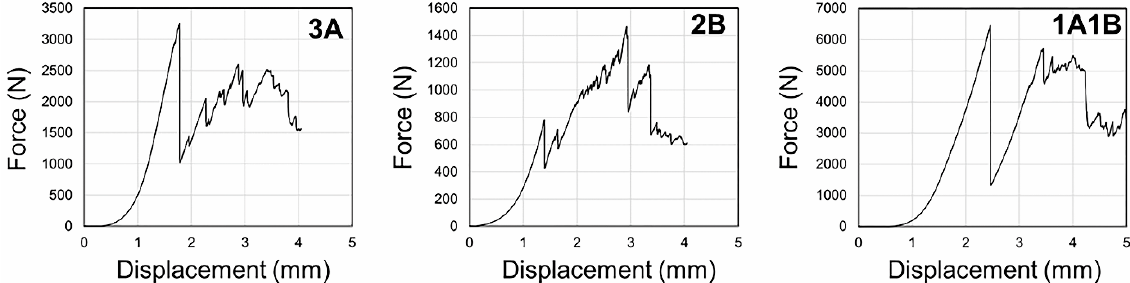
Figure 3. Force–displacement curves obtained for alumina foams fabricated from slurries 3A, 2B and